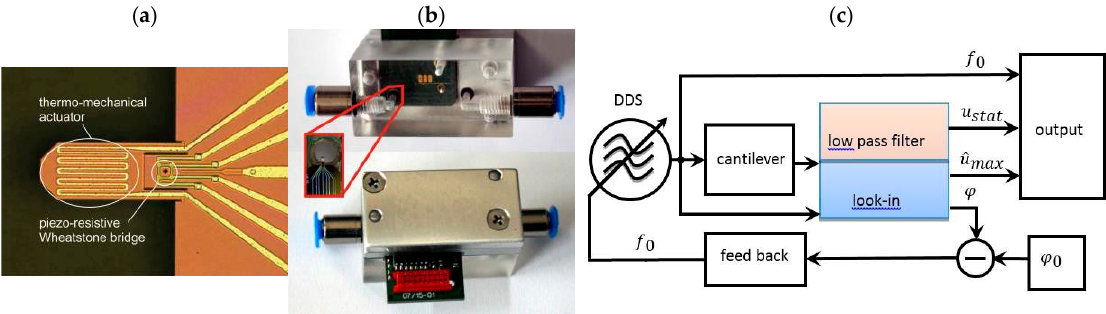
Figure 1. ( a ) Self-actuated cantilever with integrated read-out; ( b ) gas-flow sensor enclosure with cantilever and preamplifier; ( c ) diagram of PLL based sensor control with signal